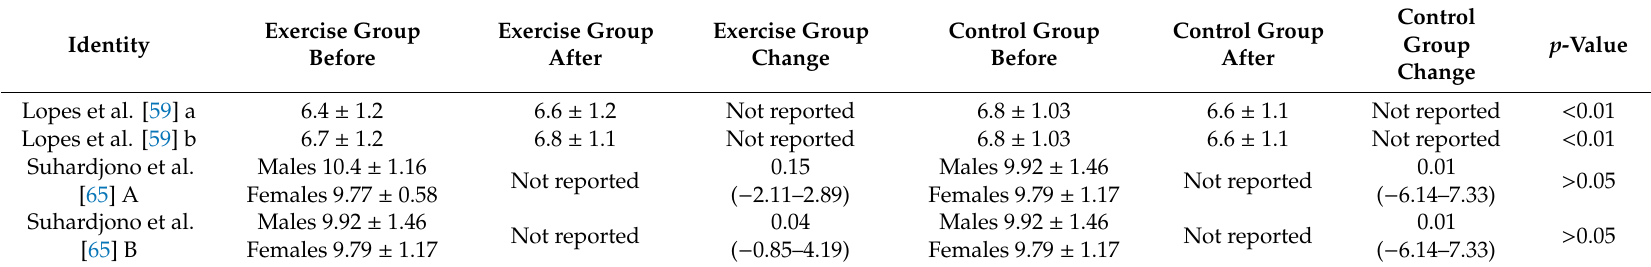
Table 6. E ff ects on SMI (kg / m 2